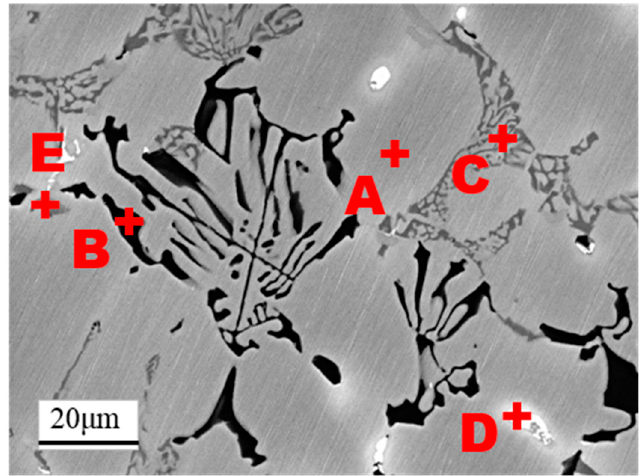
Figure 4. Scanning electron microscope (SEM) images of the Al-8Zn-6Si-4Mg-2Cu alloys.